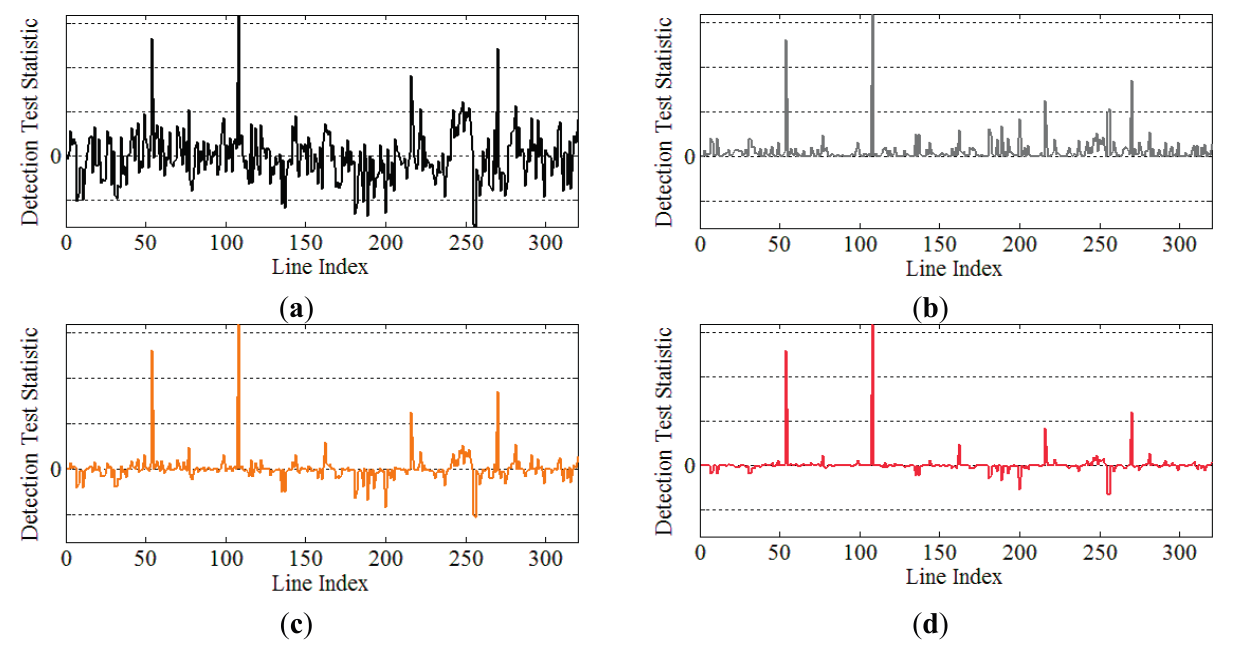
Figure 9. Detection test statistic transect plots of line 54 in synthetic dataset with adding 10 dB white noise. ( a ) CEM, ( b ) ACE, ( c ) ASMF with n = 1, ( d ) ASMF with n =